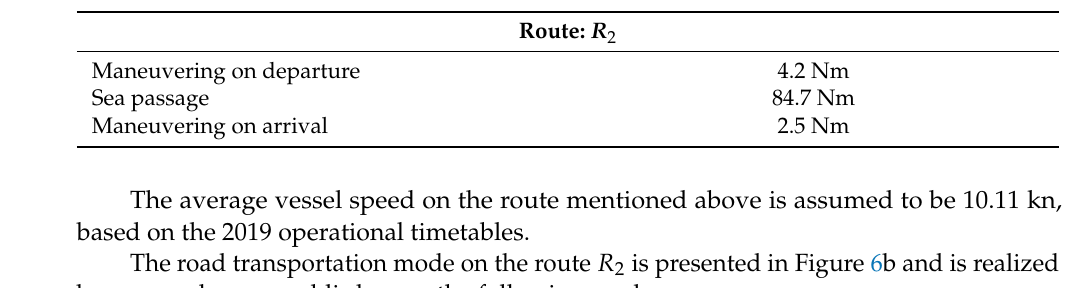
Table 12. Distances in the specific navigation modes on the route R 2